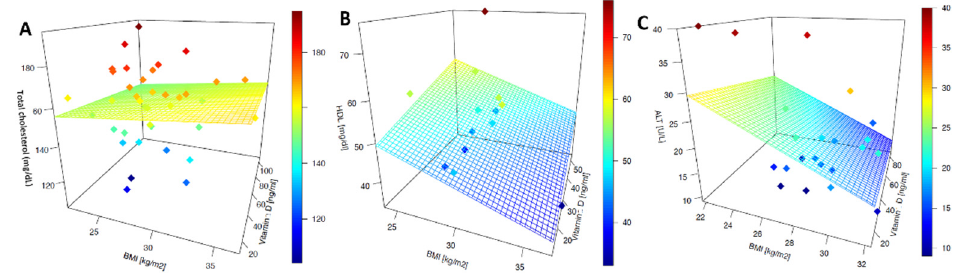
Figure 2. Vitamin D-specific laboratory-parameter multivariate linear regression (corrected for BMI) before and after vitamin D supplementation: ( A ) total cholesterol; ( B ) HDL-C; ( C ) ALT. Vitamin D supplementation was not associated with statistically significant findings when serum Apo A1 ( p = 0.18), Apo B ( p = 0.18) and triglycerides ( p = 0.31) were examined.